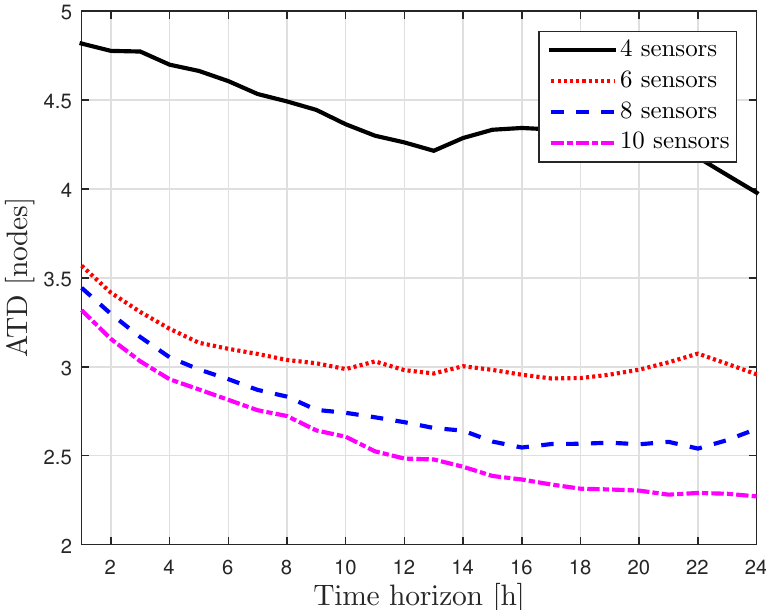
Figure 6. ATD performance for the sensor placement using different number of sensors in the simplified Hanoi